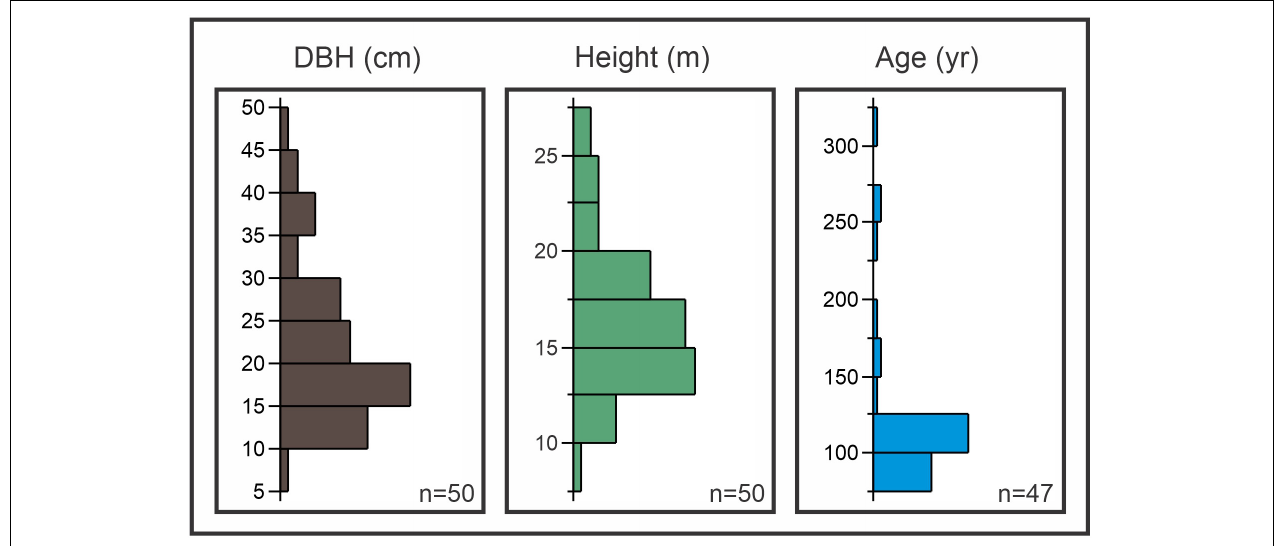
FIGURE 1 | Diameter (DBH), height, and age distribution of the trees selected for this study in 1998. Heart rot prevented aging of three trees.